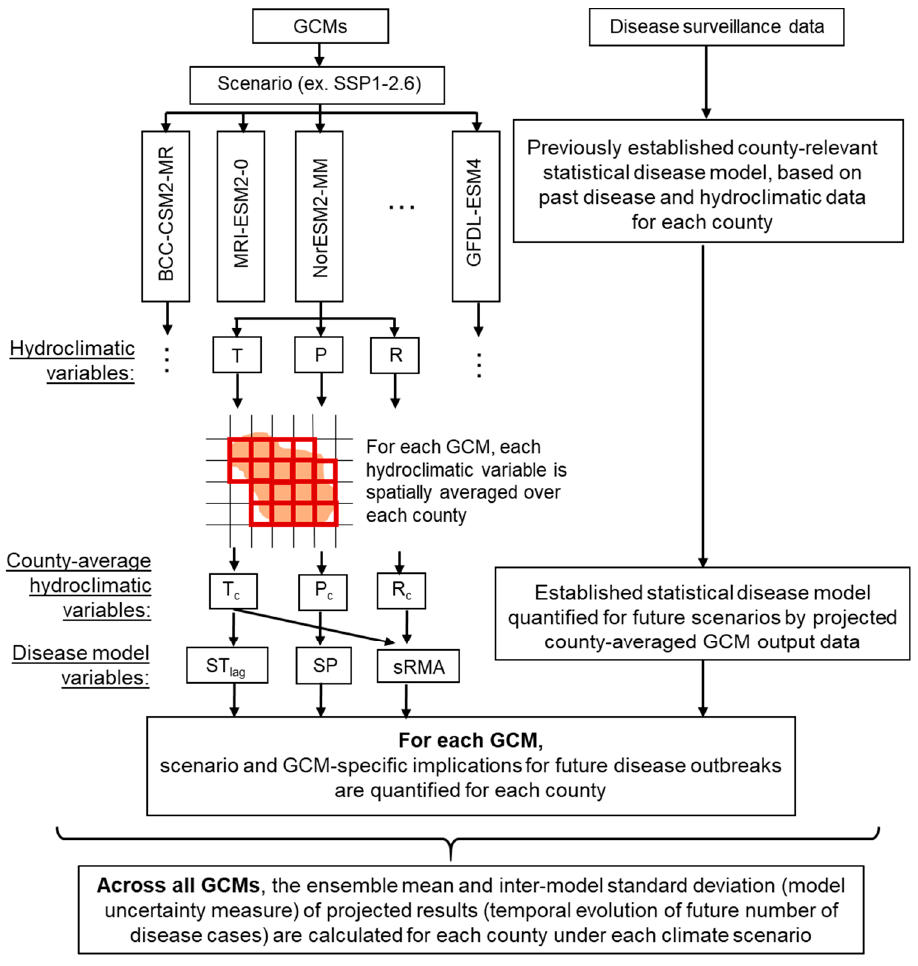
Figure 2. Schematic diagram of the model and statistical analysis approach in this study. For each county, we selected daily outputs of disease-relevant hydroclimatic variables (related to air temperature T, precipitation P, and runo ff R) for the grid cells of each global climate model (GCM) with at least 40% of their area located within each targeted county (35% for Örebro county in The Geophysical Fluid Dynamics Laboratory’s Earth System Model version 4 (GFDL-ESM4) and The Geophysical Fluid Dynamics Laboratory’s climate model version 4 (GFDL-CM4)). We spatially averaged the values of each hydroclimatic output variable of each GCM over these county grid cells to represent a corresponding county-average daily hydroclimatic variable value (air temperature T c , precipitation P c , and runo ff R c ). Furthermore, for each GCM, we assessed its hydroclimatic projection implications for the future scenario evolution of disease cases in each county, based on a previously established county-relevant statistical disease model that we quantified by preceding-year number of disease cases and relevant GCM-projected county-average hydroclimatic variables (including summer temperature in the preceding year ST lag , summer precipitation in the same year SP, and standardized relative annual mosquito abundance sRMA, which is in turn related to various river flow Q conditions). Finally, across all GCMs, we calculated the model ensemble mean and inter-model standard deviation (as a GCM uncertainty measure) of scenario-implied possible future evolution of disease cases in each county. SSP1-2.6: Shared Socioeconomic Pathways (SSP) with emissions driven by sustainable practices to produce radiative forcing of 2.6 Wm − 2 by 2100; BCC-CSM2-MR: The Beijing Climate Center Climate System Model, Version 2-MR; MRI-ESM2-0: The Meteorological Research Institute Earth System Model, Version 2.0; NorESM2-MM: The Norwegian Earth System Model, Version 2-MM.